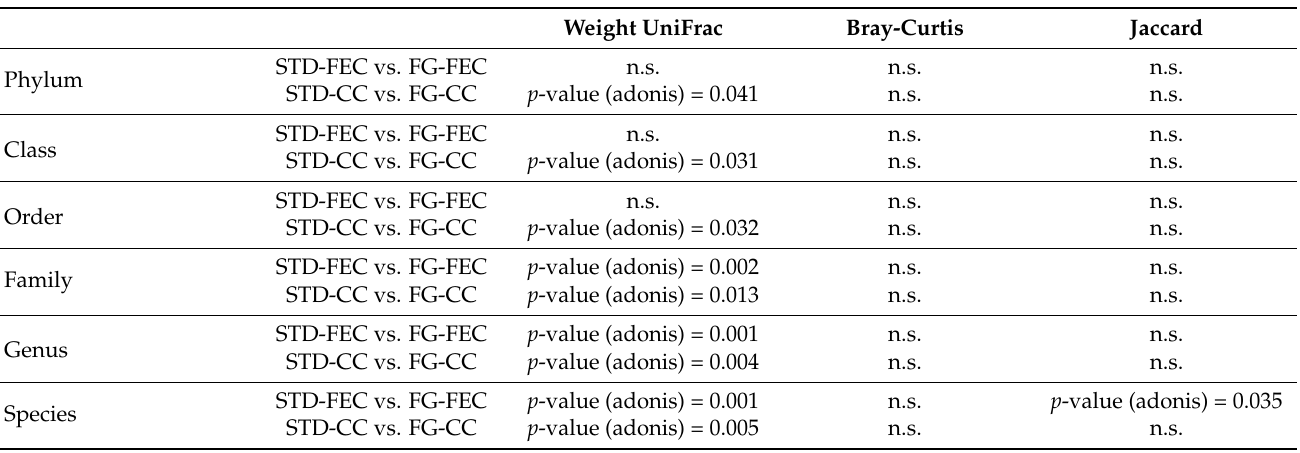
Table 2. β -diversity of the fecal and cecal microbiota in the STD and FG groups of rats ( n = 8–9/group) at the end of the study (week 23). Weight UniFrac Bray-Curtis